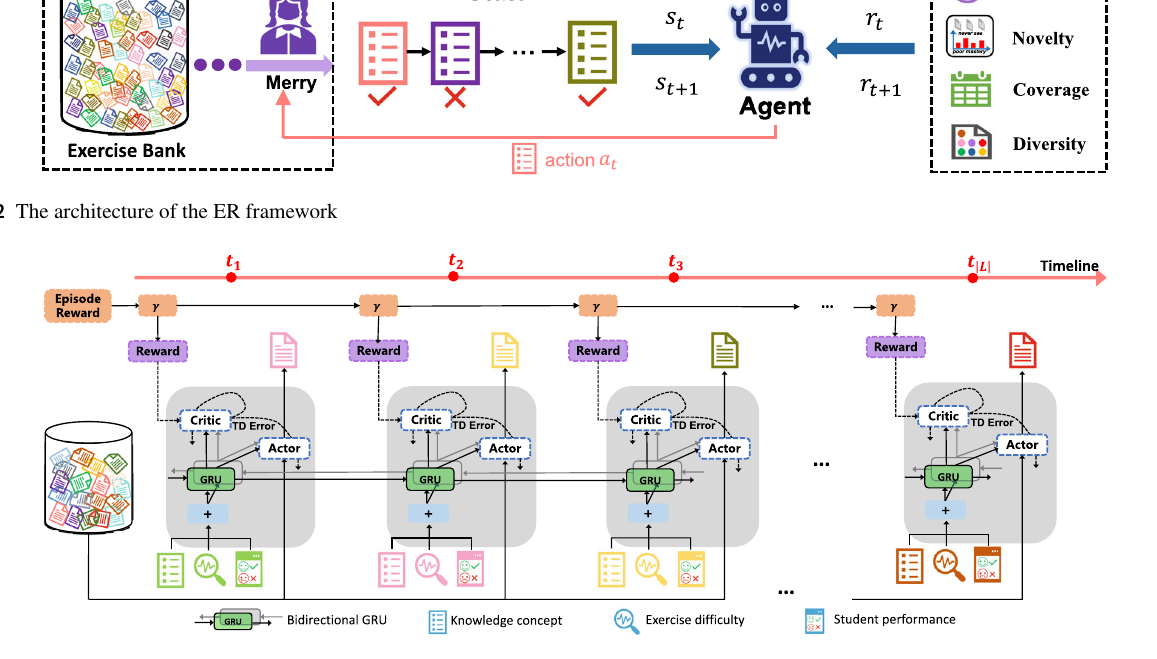
Fig. 3 The architecture of the DMoSwR-DRL framework